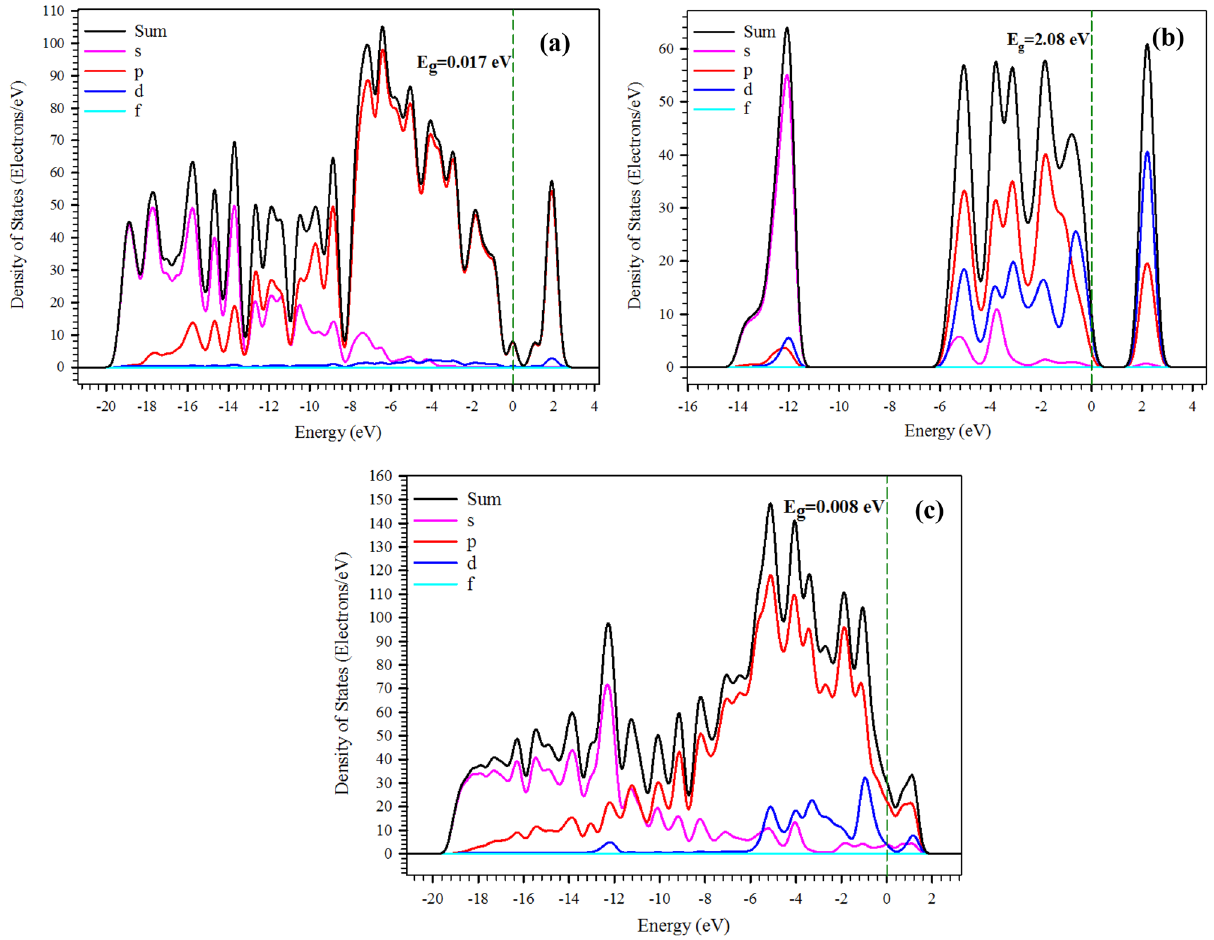
Figure 2. PDOS diagrams for: ( a ) CNT; ( b ) MoS 2 ; and ( c ) MoS 2 /CNT. The Fermi energy level is set at